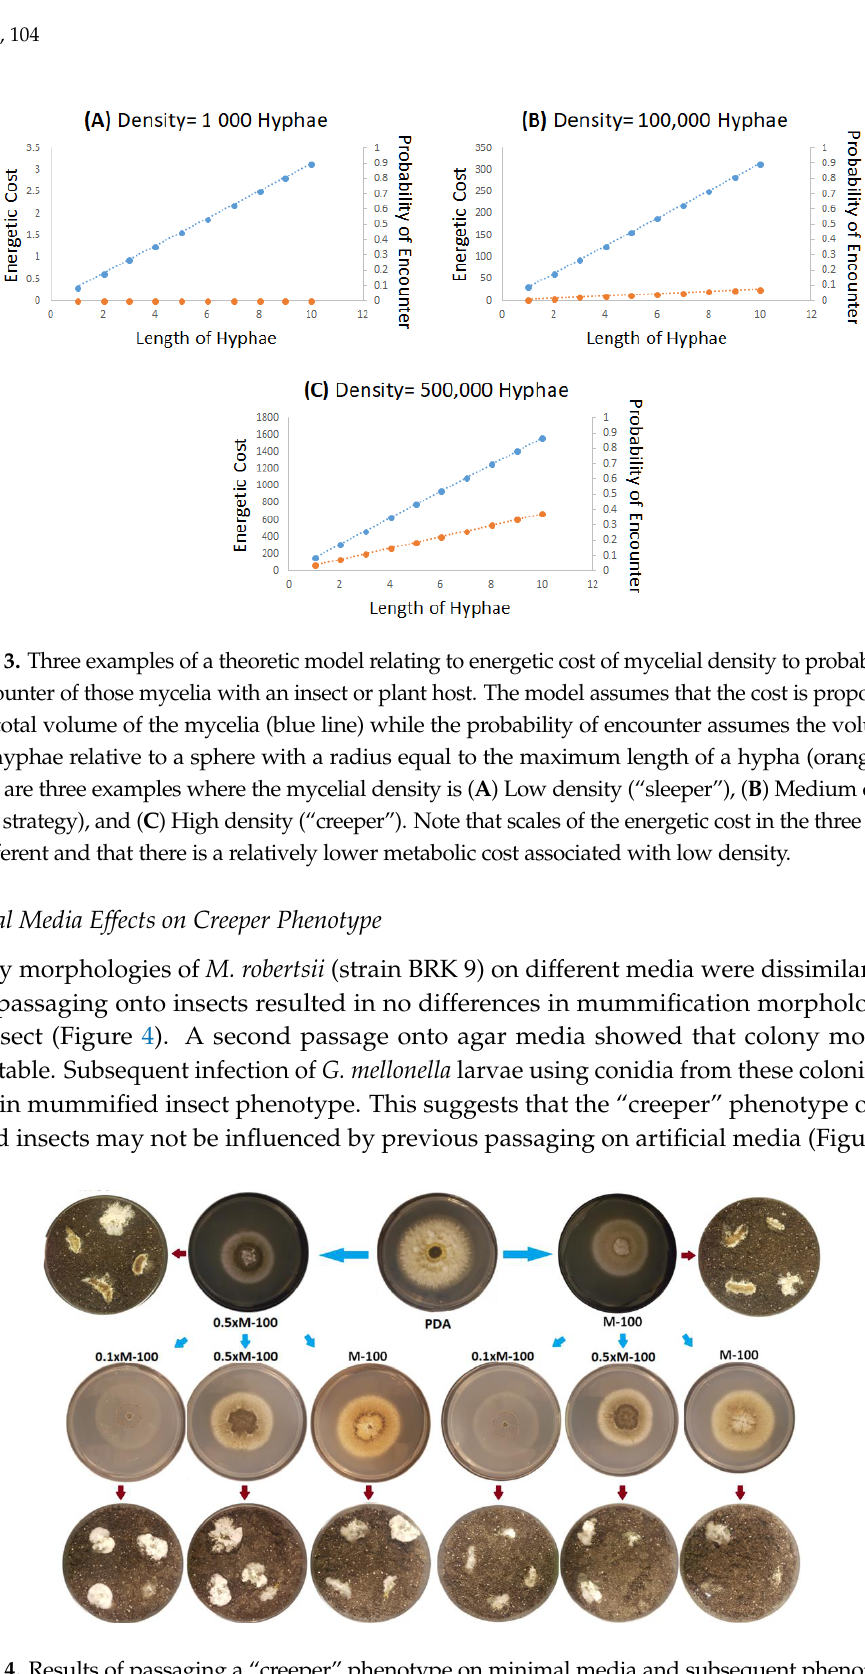
Figure 4. Results of passaging a “creeper” phenotype on minimal media and subsequent phenotype of the mummified insect. Red arrows represent passage from artificial media to the insect while blue arrows represent passage from artificial media to artificial media. Colony phenotype is dependent on the strength of M100. However, the “creeper” phenotype was observed in infected insects regardless of media type.